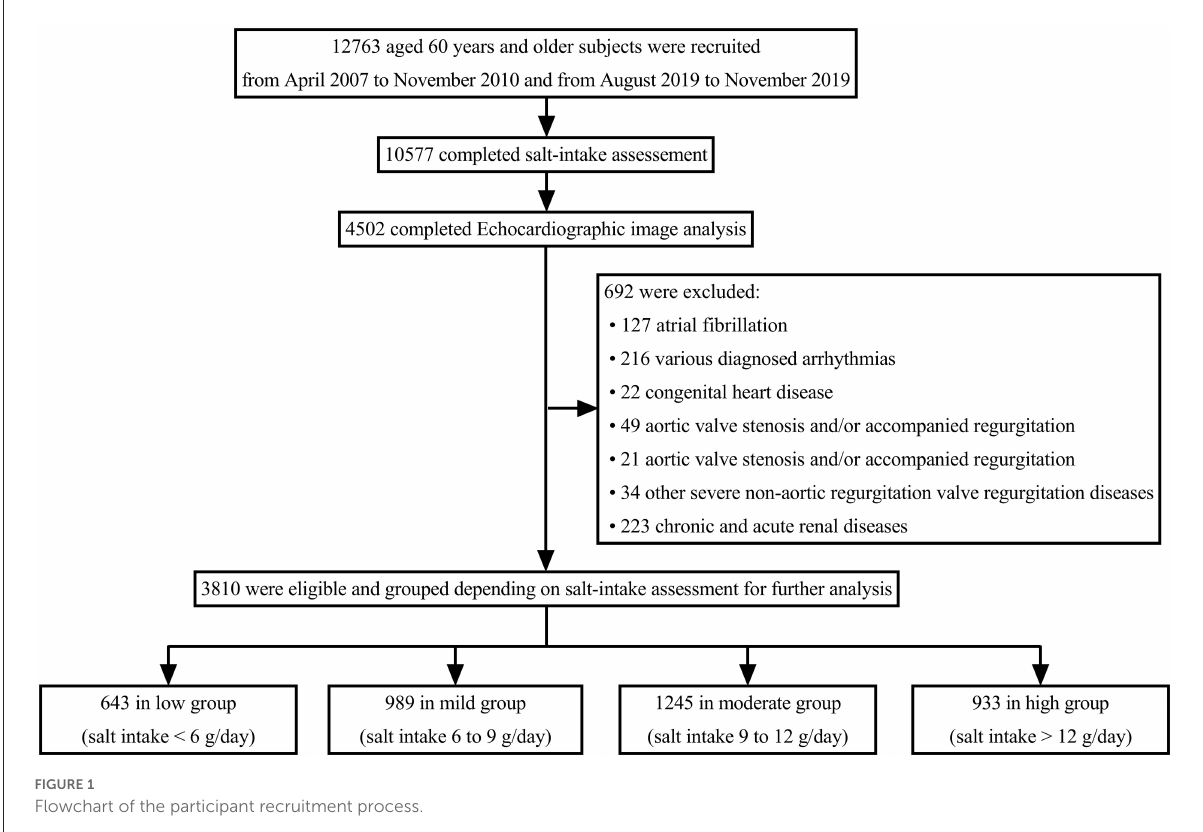
the serum level of hsCRP after adjustment for